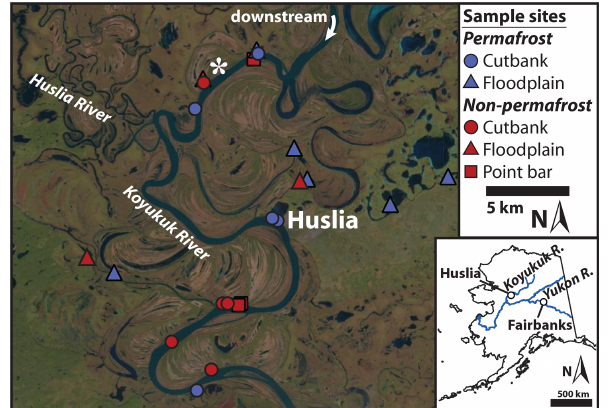
Figure 2. Sample locations on the Koyukuk River floodplain. Loca- tions are coded for sites where we sampled ice-cemented permafrost versus ice-poor ground inferred to be non-permafrost. Sample sites are located near the village of Huslia, in central Alaska, and the river flows towards the south past the town. Sampling locations are mapped on Landsat imagery, with the white star marking the loca- tion of Fig. 1a (drone photo taken looking east). The inset map was generated using the “Alaska Coast Simplified” and “Major Rivers” shapefiles from the Alaska State Geo-Spatial Data